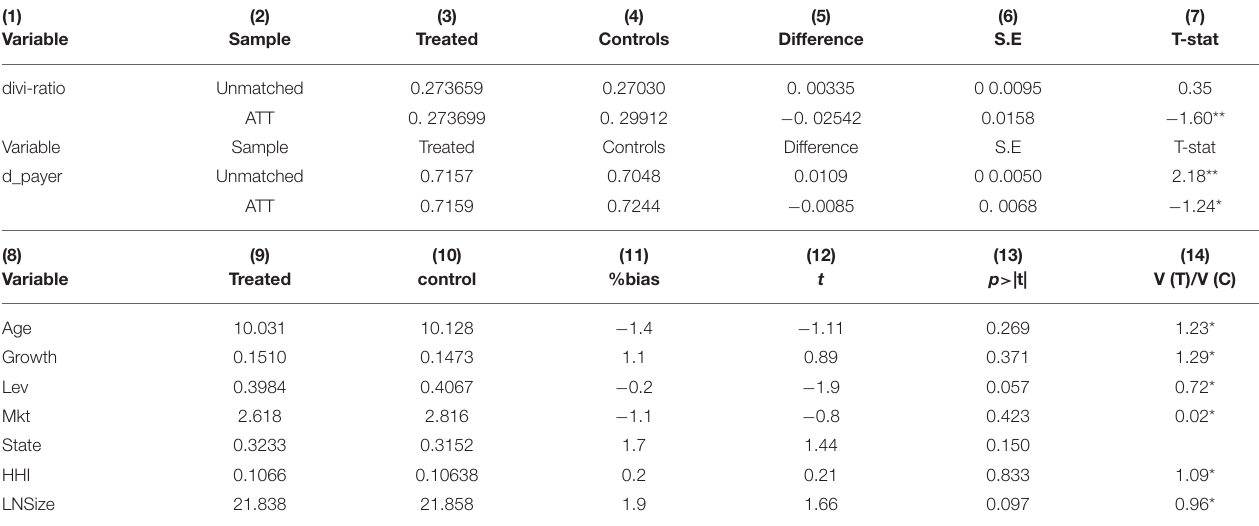
TABLE 4 | Average processing effect of PSM (ATT).